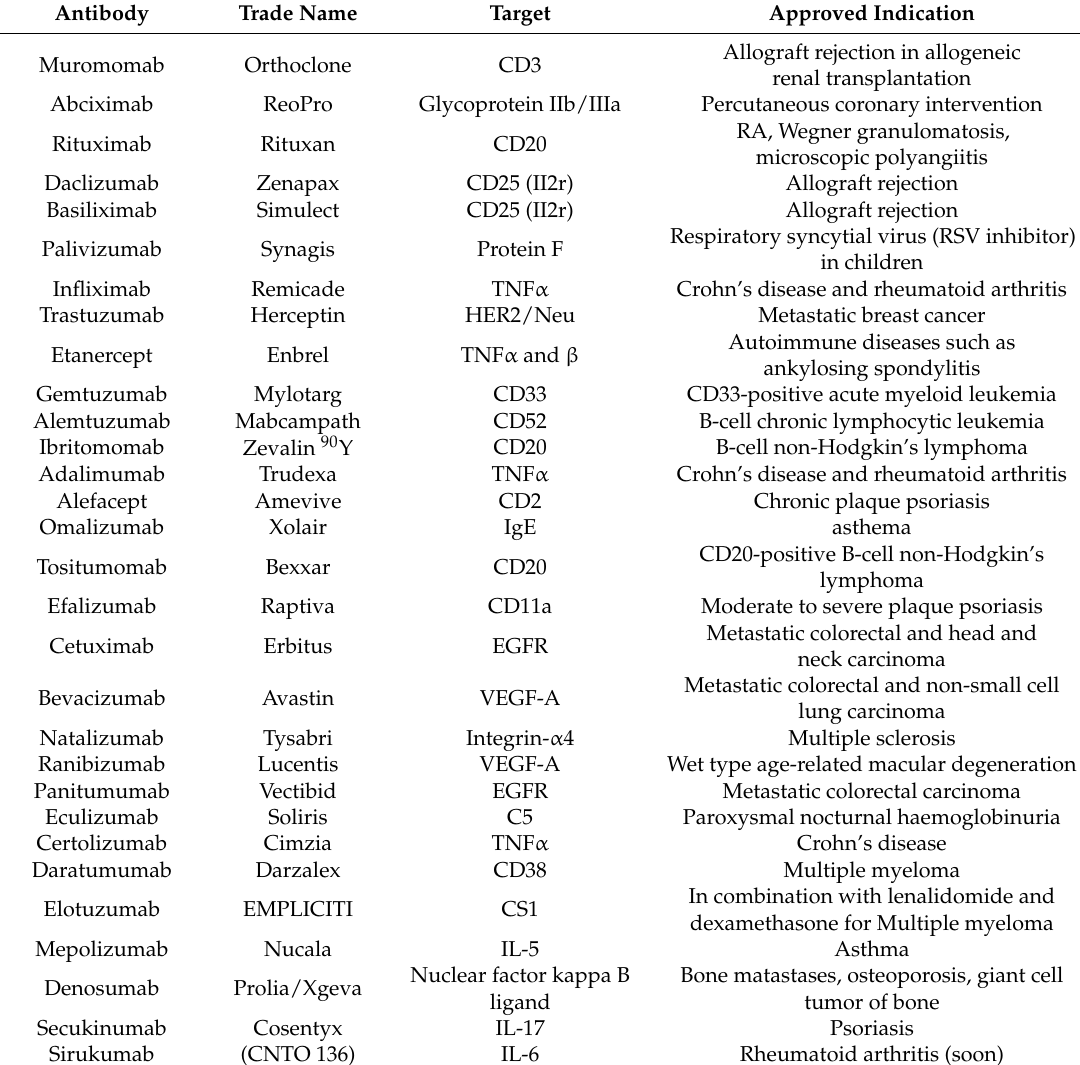
Table 3. Monoclonal antibodies approved by FDA for therapeutic